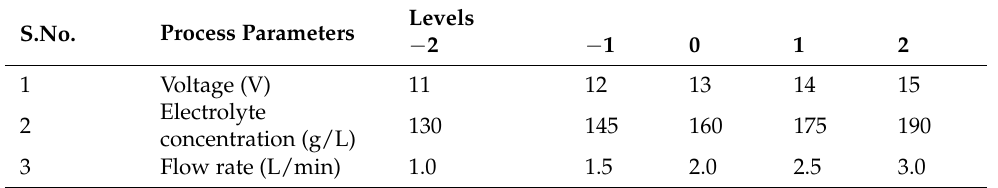
Table 3. Process parameters and levels.